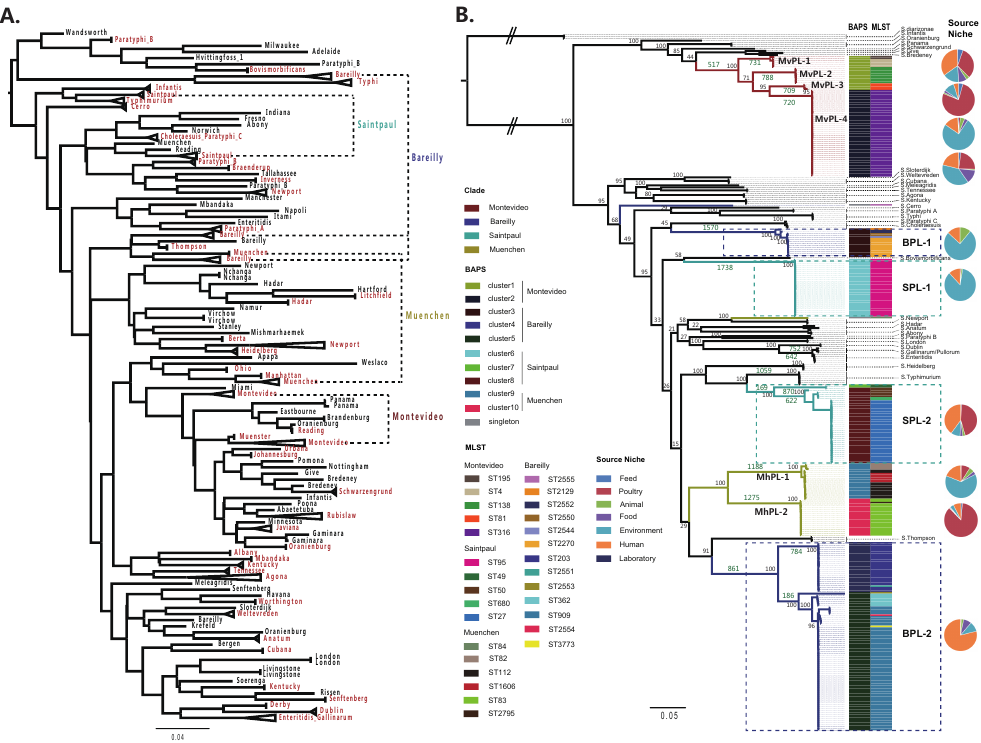
Figure 1. Phylogenetic analysis of the Salmonella strains. ( A ) Maximum-likelihood (ML) tree based on the 7 multi-locus sequence typing (MLST) genes among 4498 strains. Clade labels shown in red color clustered with more than 3 strains. The clusters of putative polyphyletic serovars marked with dotted lines. ( B ) Core genome phylogenetic analysis of 347 strains. Serovars Montevideo, Bareilly, Saintpaul, and Muenchen were designated as MvPL, BPL, SPL, and MhPL, respectively. The black values of the primary nodes of the tree are the bootstrap values (100 replicates). The single nucleotide polymorphisms (SNPs) on important branches are also shown in green. The colored blocks next to the tree indicate the Bayesian Analysis of genetic Population Structure (BAPS) clusters and sequence types (STs) that an isolate belongs to. The pie chart represents source niche of strains carrying each lineage-specific